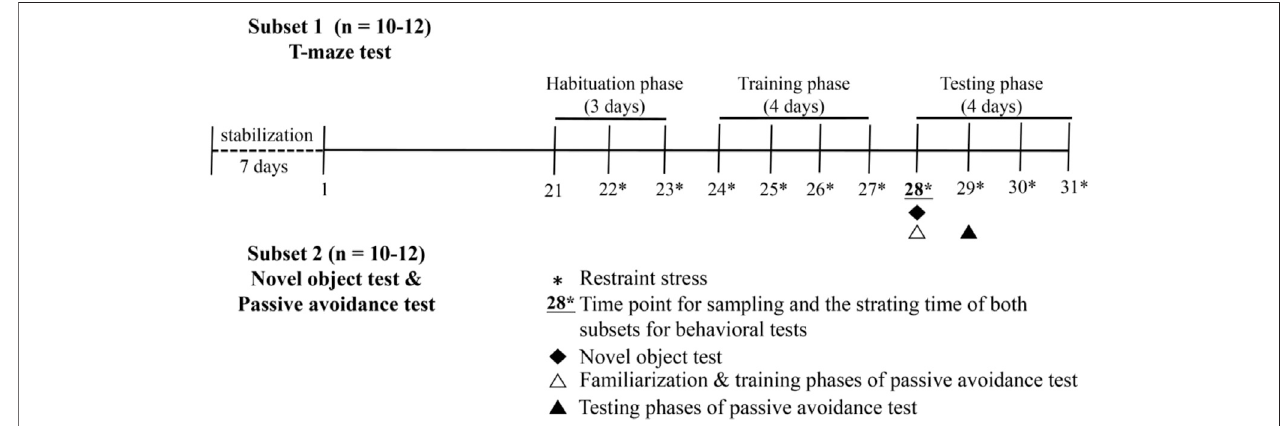
FIGURE 1 | Flow diagram of behavioral